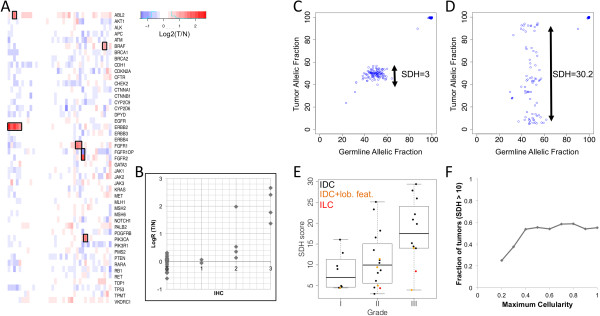
Somatic rearrangements. (A) Heatmap representing the average logR ratio of tumor/germline coverage depth observed on all amplicons of a given gene (rows) in the sequenced samples (columns). Red, gains; blue, losses. Black frames indicate significant changes (P <5.6 × 10–6). (B) The logR ratios of tumor/germline coverage depth of the Her2 gene correlate with the results of immunohistochemistry. (C), (D) Scatterplot representing the allelic fraction of the germline variants in the germline DNA (x axis) and tumor DNA (y-axis) for tumors showing a low (C) or high (D) level of chromosomal instability. The standard deviation of heterozygotes (SDH) score, calculated from the standard deviation of the allelic fraction of heterozygous single nucleotide polymorphisms in the tumor, is indicated. (E) Distribution of SDH scores in the sequenced cohort as a function of histological grade (x axis). Invasive lobular carcinoma (ILC; red) and invasive ductal carcinoma (IDC) showing lobular features (orange) are indicated. (F) Cumulative fraction of tumors with high SDH score (y axis), at increasing tumor cellularity (x axis). IHC, immunohistochemistry.